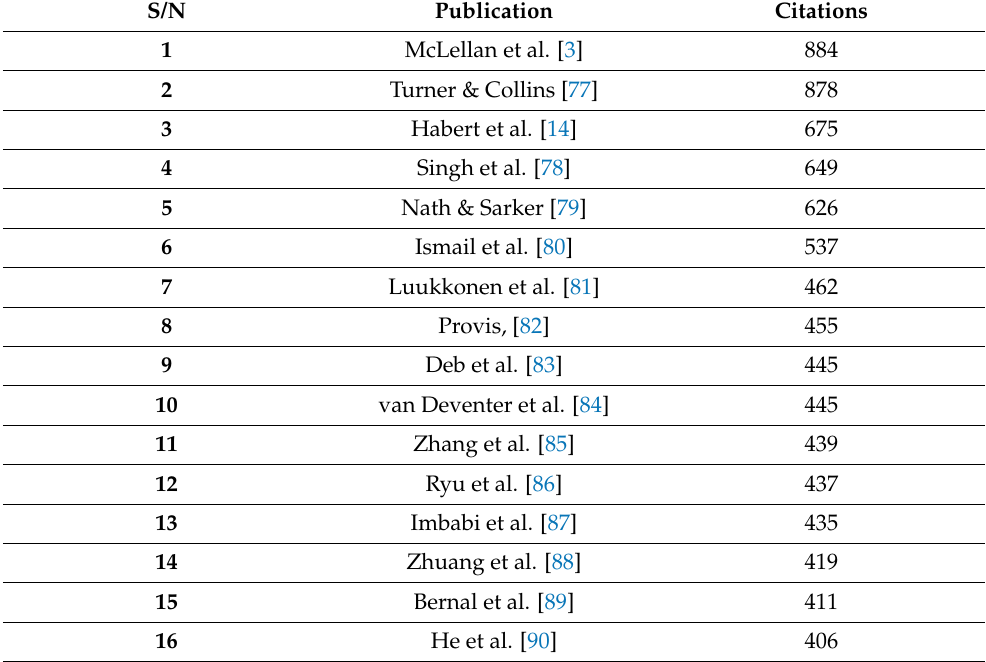
Table 6. Documents with a minimum of 400